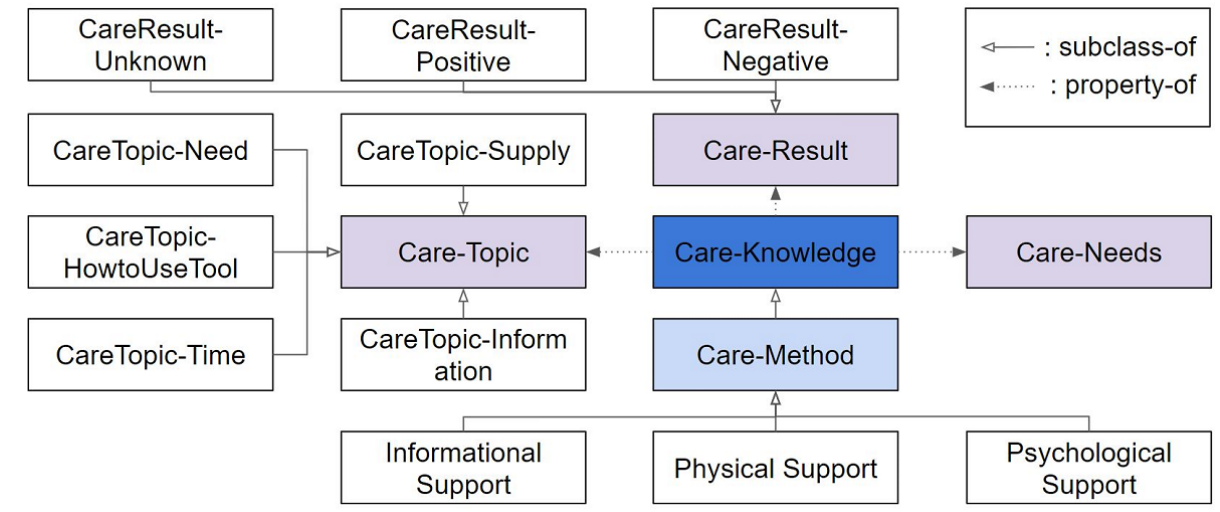
Figure 4. The structure of the “Care Knowledge” class in care ontology.